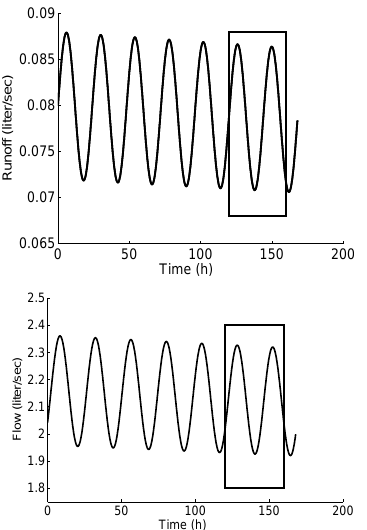
Figure 6. Sample runoff pattern (top) and resulting streamflow so- lution at the outlet in the uniform case (bottom) for k = v amine the oscillations more closely for different velocities, we will focus on a small section of the solution (highlighted by a box in each panel).